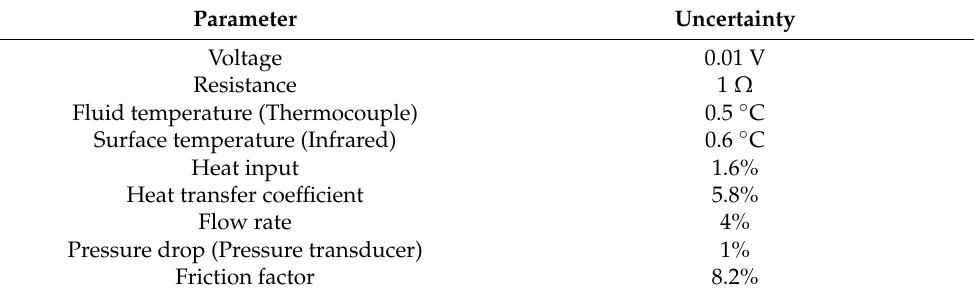
Table 1. Uncertainties in the test